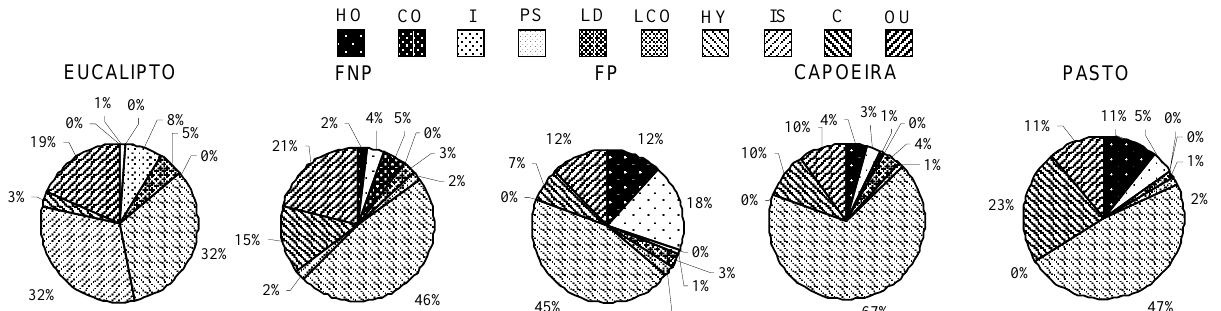
Figura 3. Distribuição dos grupos de fauna identificados na serapilheira das diferentes coberturas vegetais no inverno. HO- Homoptera; CO- Coleoptera; I- Isopoda; PS- Pseudoscorpionida; LD- Larva de Diptera; LCO- Larva de Coleoptera; HY- Hymenoptera; IS- Isoptera; C- Collembola; OU- Outros; FNP- Floresta não preservada; FP- Floresta preservada. * Os dados obtidos no pasto são referentes ao sistema solo- serapilheira, pois não houve separação dos compartimentos.